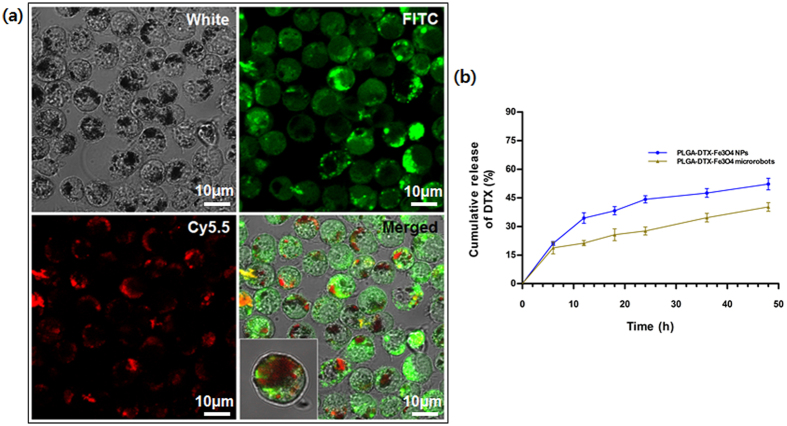
Confirmation of internalization of PLGA-DTX-Fe3O4 NPs into macrophages.(a) Identification of intracellular fluorescence from PLGA-DTX-Fe3O4 NPs by confocal microscopy. PLGA-DTX-Fe3O4 NPs were linked with streptavidin-PerCP-Cy5.5 (red) and the macrophages were stained using FITC (green) (Scale bar 10 μm). (b) Cumulative release rate of DTX from macrophage-based microrobots with PLGA-DTX-Fe3O4 and NPs.